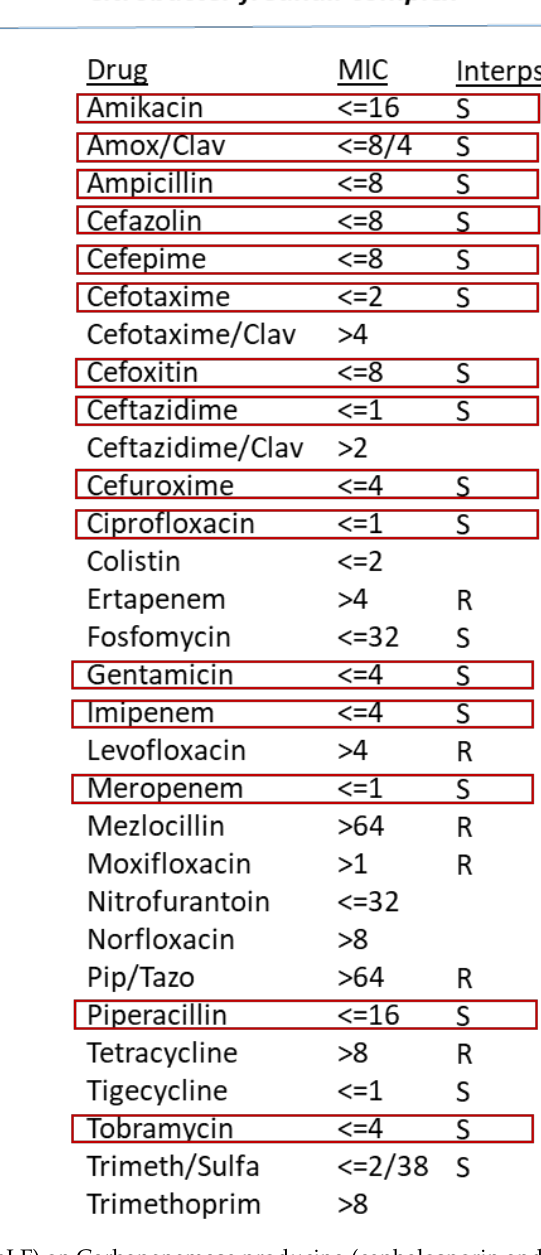
Figure 4. Demonstration of effect bovine lactoferrin (bLF) on Carbapenemase producing (cephalosporin and carbapenem resistant) and ciprofloxacin resistant Citrobacter